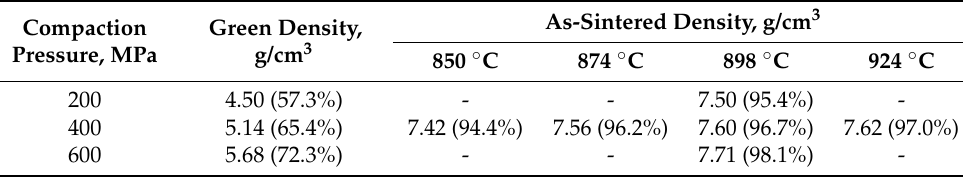
Table 3. Mean values of green and as-sintered densities 1 .